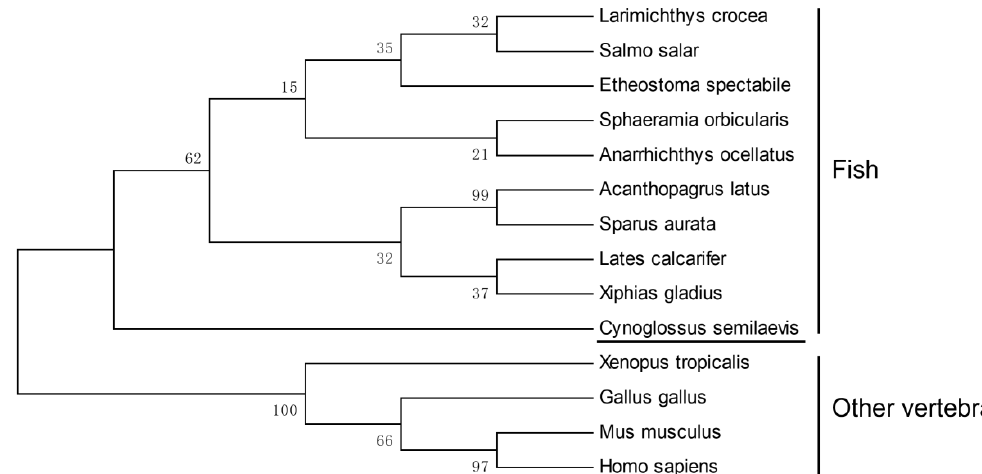
Figure 2. Phylogenetic analysis of RCHY1 from C. semilaevis and other vertebrates. Numbers at nodes represent NJ bootstrap values. The GenBank accession numbers of the amino acid sequences were as follows: Cynoglossus semilaevis , XP_024908814.1; Acanthopagrus latus , XP_036955304.1; Sparus aurata , XP_030271559.1; Sphaeramia orbicularis , XP_030000139.1; Etheostoma spectabile , XP_032372704.1; Anarrhichthys ocellatus , XP_031705216.1; Lates calcarifer , XP_018524733.1; Xiphias gladius , XP_040010866.1; Larimichthys crocea , TMS03383.1; Salmo salar , XP_014026963.1; Xenopus tropicalis , NP_001011487.1; Gallus gallus , NP_001074357.1; Mus musculus , NP_080833.1; Homo sapiens , NP_056251.2.